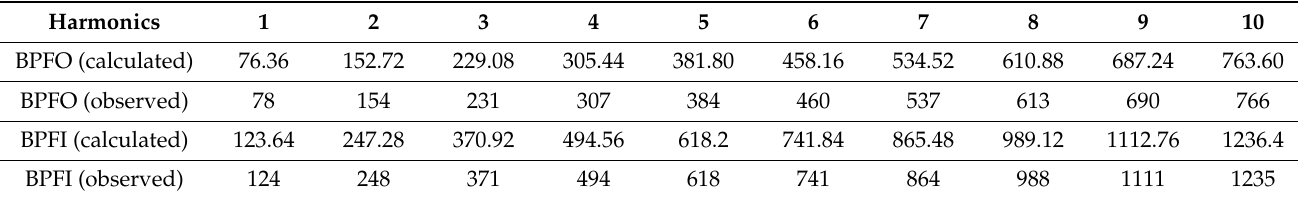
Table 6. Calculated bearing fault characteristic frequency harmonics for State